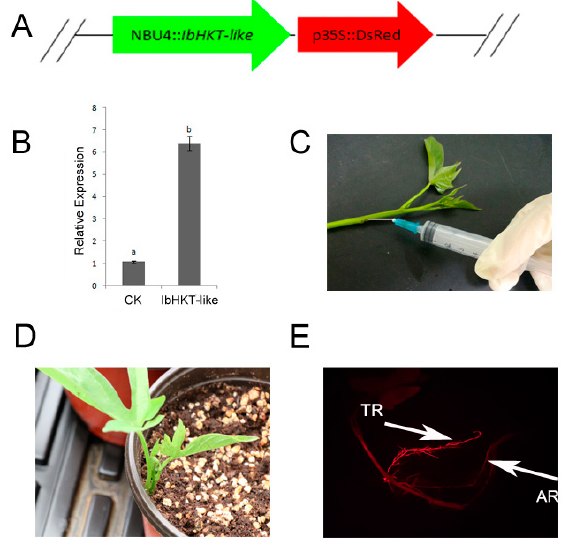
Figure 2. Generation of IbHKT-like gene overexpressing roots in sweet potato ( A ) NBU4:: IbHKT-like - CaMV35S::DsRed expression cassettes. ( B ) Expression pattern of IbHKT-like gene in transgenic roots (TR) and non-transgenic roots, with relative expression of IbHKT-like gene on the ordinate. IbARF was used as the internal reference for data processing. Values indicated the mean and standard deviation of biological repetitions ( n = 3): different letters indicated extremely significant p < 0.05. ( C ) Injecting sweet potato stem segments with Agrobacterium rhizogene s bacterial solution. ( D ) Seedlings grown in a pot after injection. ( E ) Identification of transgenic roots (with red fluorescent, TR).